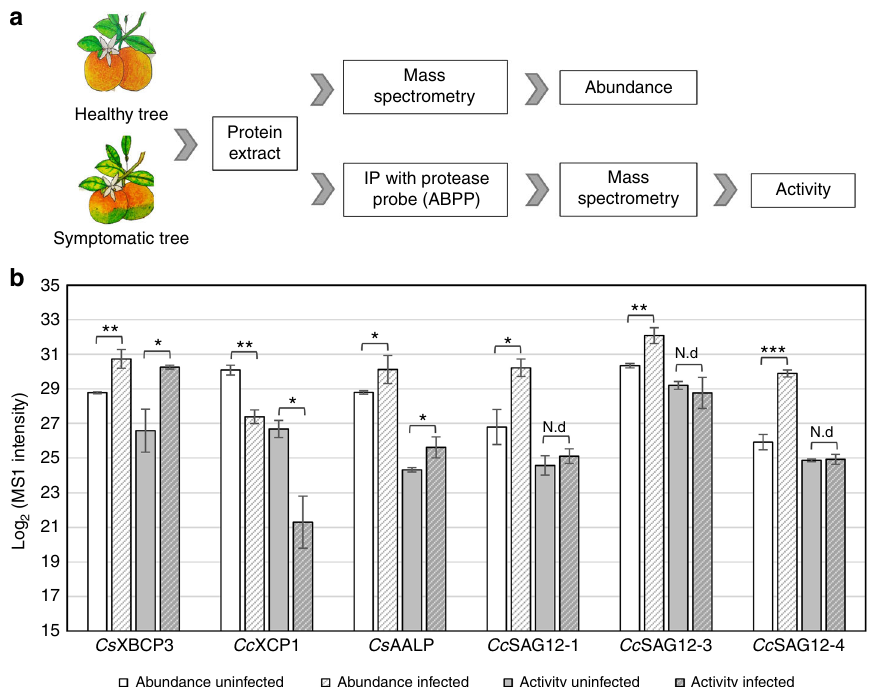
Fig. 4 Cs SAG12s increase in abundance but not activity in infected citrus. a Diagram illustrating the experimental approach for detecting abundance and activity of Cs PLCPs in healthy and infected Navel oranges ( C . sinensis ) from a Texas grove using mass spectrometry. b Abundance and protease activity of six PLCPs belonging to four subfamilies in citrus leaf samples. Leaf tissue was ground in Tris buffer and divided into two to assess abundance and activity. PLCP abundance was tested using an in-solution digest coupled with mass spectrometry. For activity, the addition of DCG-04 permits the labeling of active PLCPs. Active PLCPs were captured and identi fi ed by streptavidin IP coupled with mass spectrometry. Mean ± standard error of three replicates is shown. Asterisks (*) indicate statistically signi fi cant differences based on the two-tailed Student ’ s t -test. N.d = no difference, p < 0.05 = *, p < 0.01 = **, p < 0.001 = ***. The gene IDs are Cs XBCP3 (orange1.1g012960m), Cc XCP1 (Ciclev10001665m), Cs AALP (orange1.1g036910m), Cc SAG12-1 (Ciclev10005334m), Cs SAG12-3 (orange1.1g018958m), and Cs SAG12-4 (orange1.1g019063m). Jessica Franco created the citrus images in panel a by